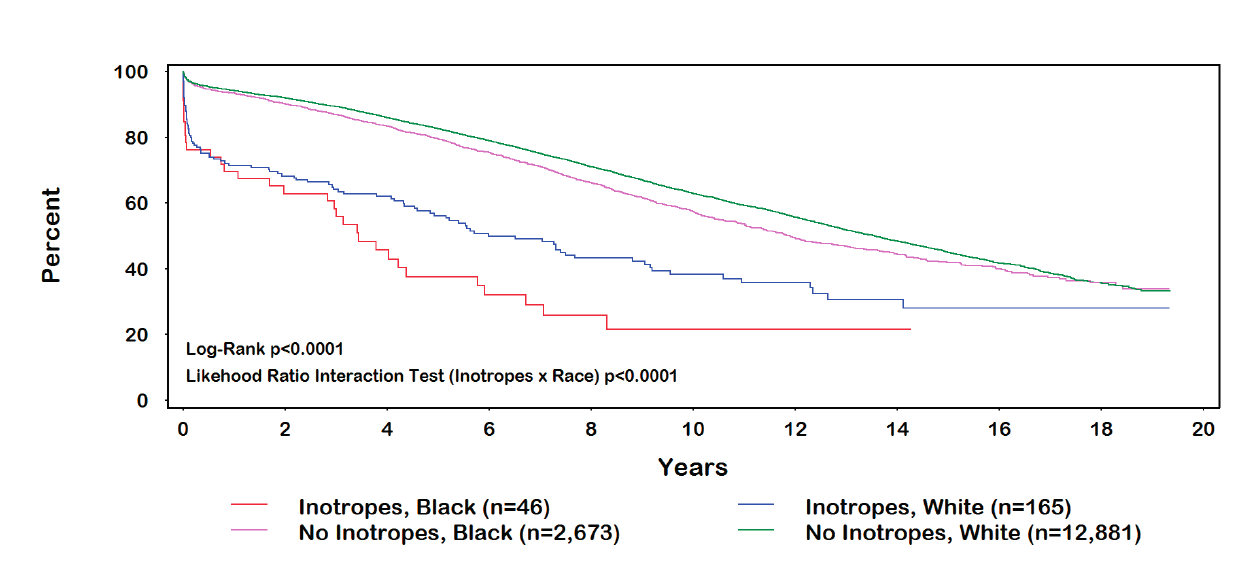
Figure 1. Inotrope use by